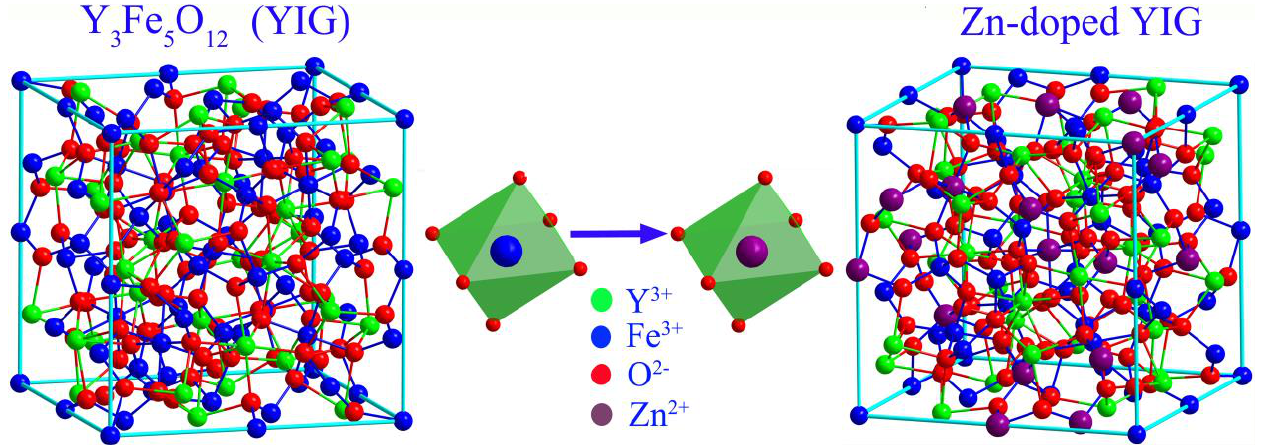
Figure 4. The variation in saturation magnetization and coercivity.